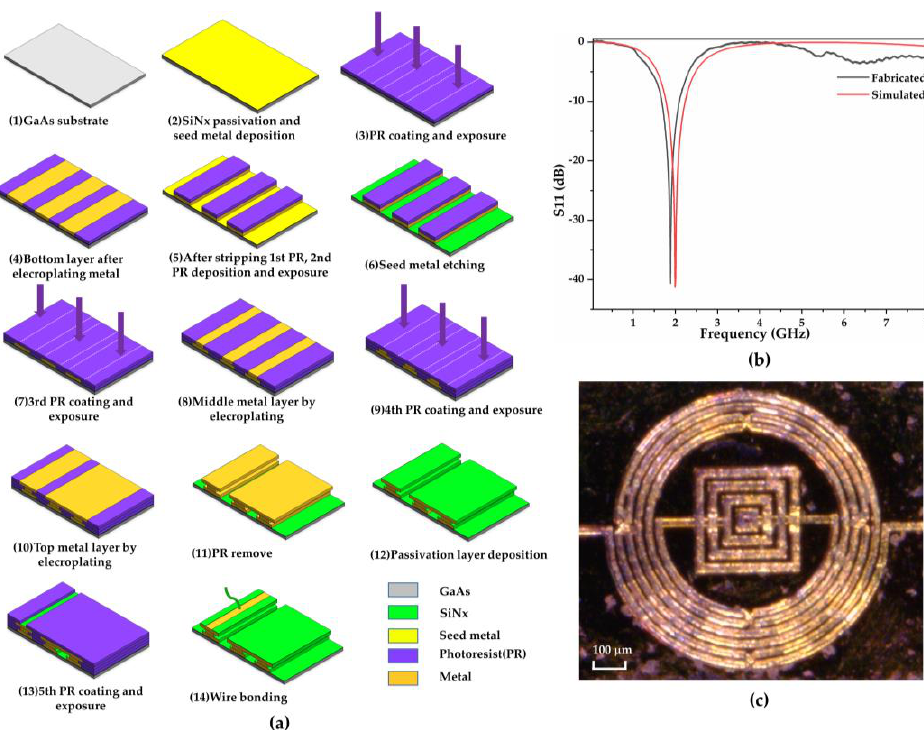
Figure 2. Fabrication process and results for the sensors: ( a ) The fabrication process; ( b )